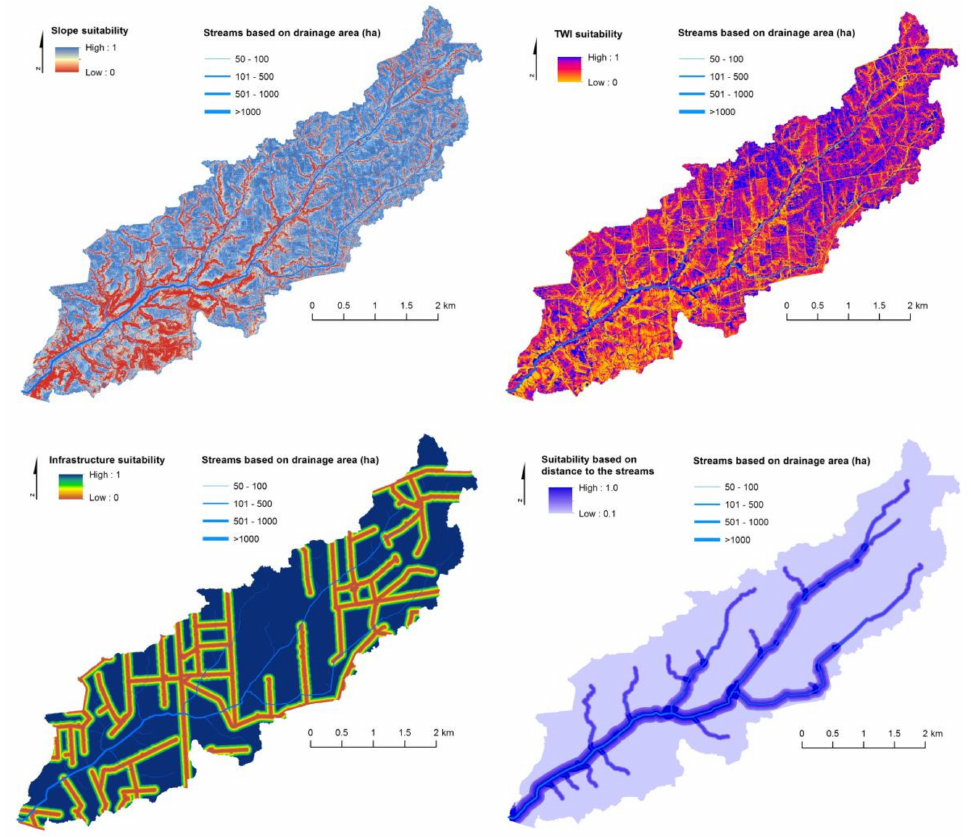
Figure 4. Suitability maps used to create the final wetland suitability map. TWI represents the topographic wetness index, and “infrastructure” represents the distance to the nearest road, farmstead, or other human structure that must be protected against